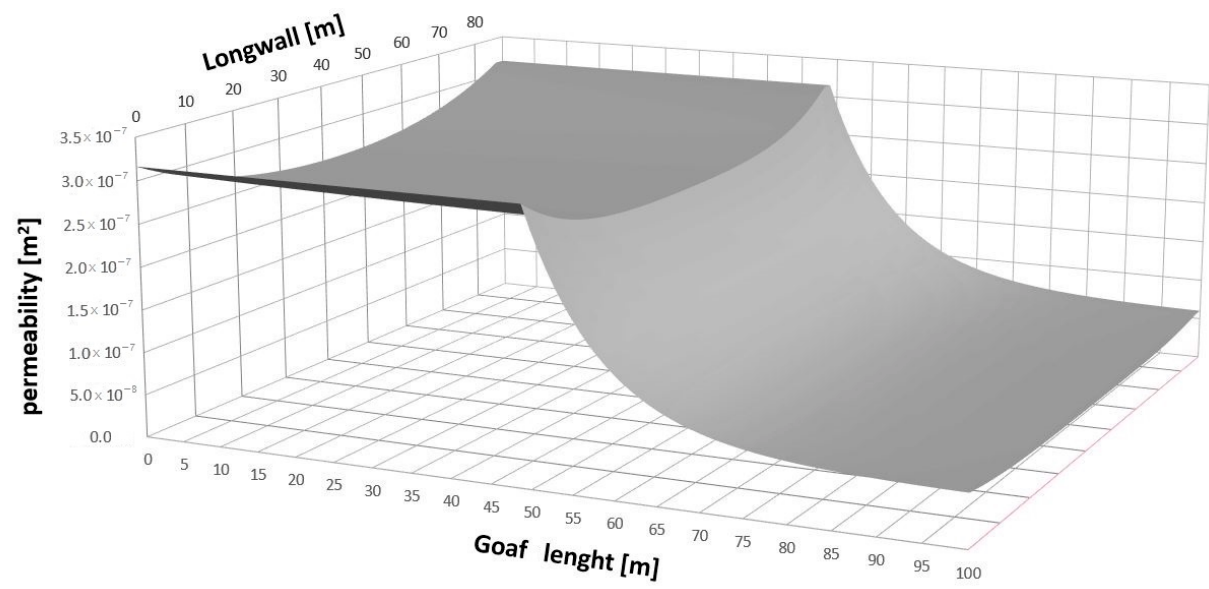
Figure 6. Permeability distribution—perspective view.